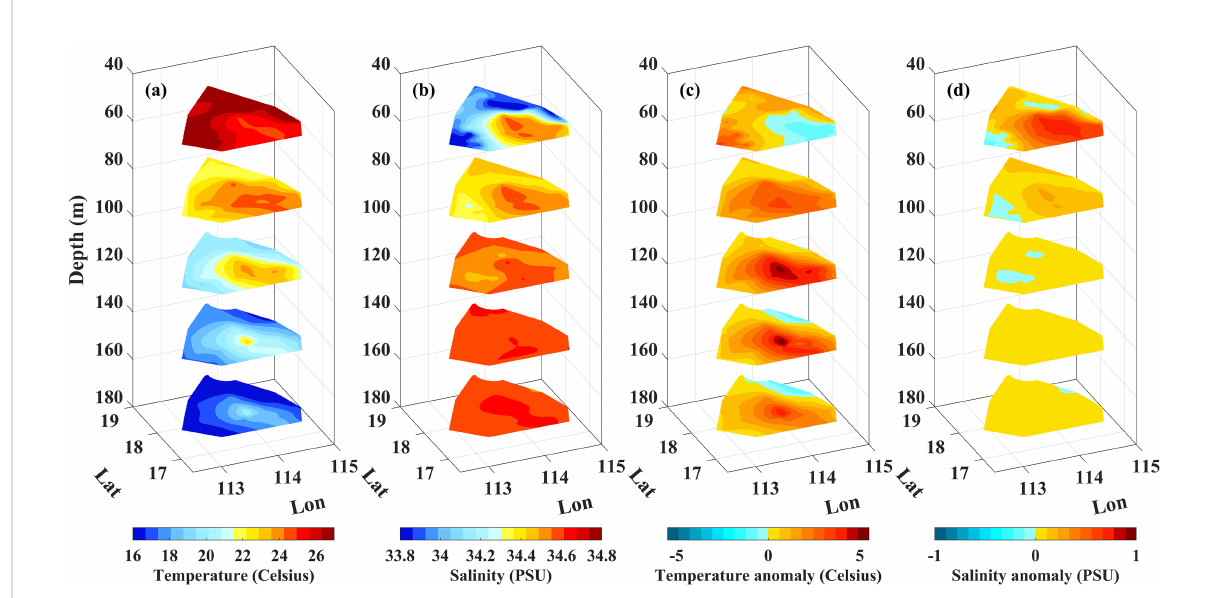
FIGURE 4 3D structures of the warm eddy. The (A) T (unit: °C), (B) S (unit: PSU), (C) TA (unit: °C), and (D) SA (unit: PSU) slices at depths from 50 m to 170 m with an interval of 30 m are shown from left to right